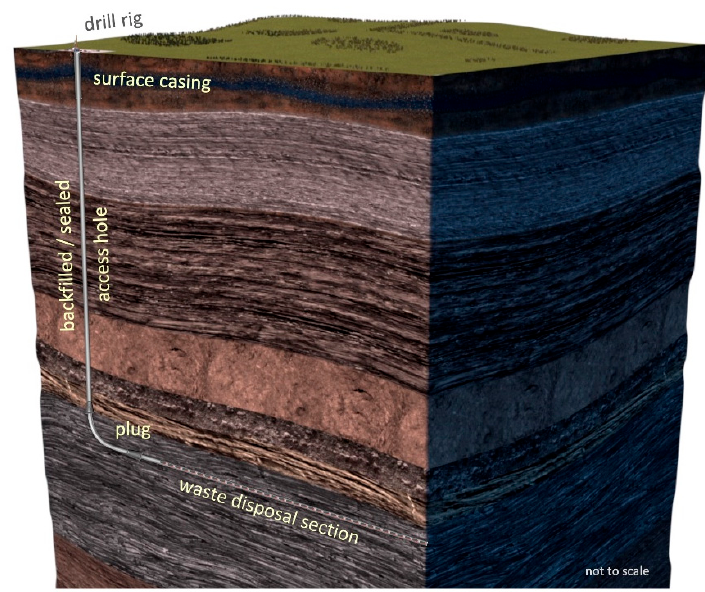
Figure 1. Depiction of the deep horizontal drillhole system with a vertical access hole and a horizontal waste disposal section.